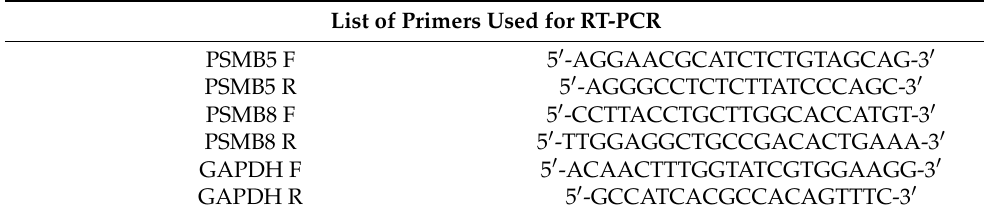
Table 1. List of primers used for RT-PCR. List of Primers Used for